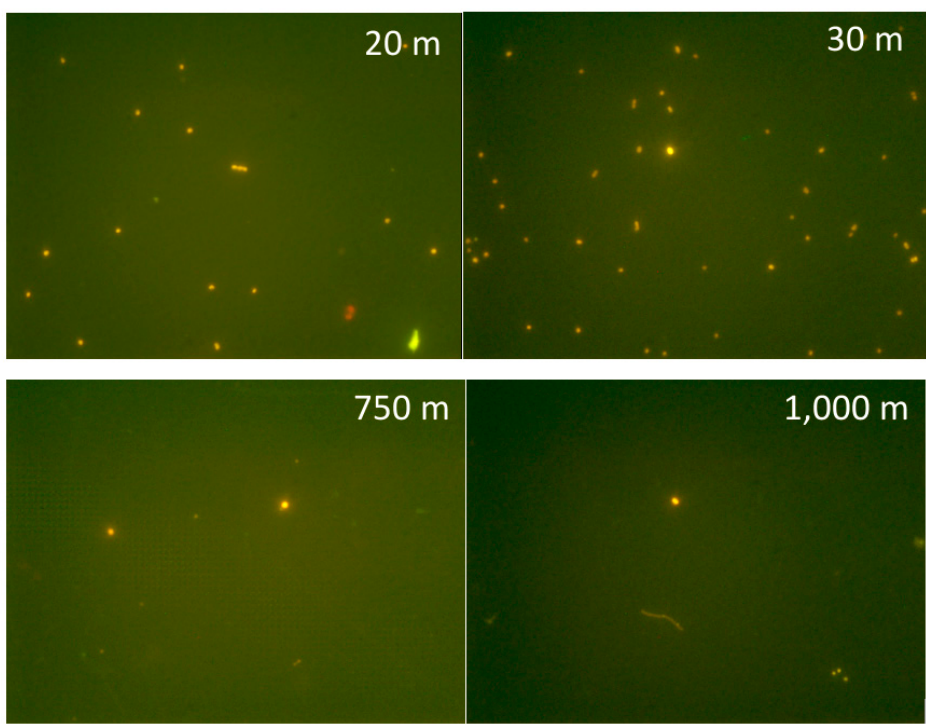
Figure 7. Picocyanobacteria from different depths (20, 30, 750, 1000 m), Black Sea, station 307, (epifluorescence microscopy, Zeiss Axioplan, 1250×, blue filters).